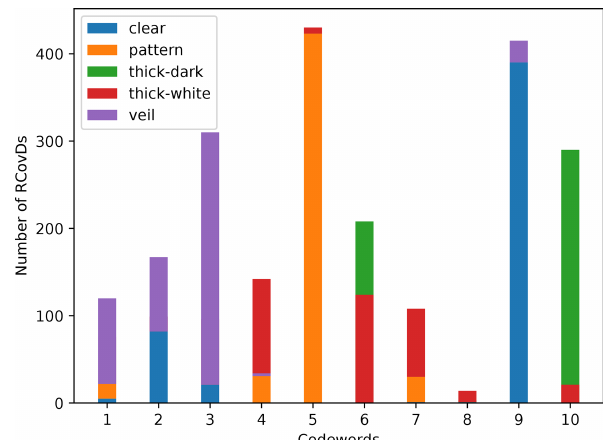
Figure 4. Histogram of RCovDs from different cloud types on SWIMCAT dataset. RCovDs from different cloud types have dis- tinctive codeword distributions. RCovD distributions of clear sky, pattern and thick dark clouds are relatively concentrated, while the distributions of thick white and veil clouds are slightly scattered. RCovDs of veils clouds and clear sky are assigned to almost the same codewords, which makes the categorization of these two types